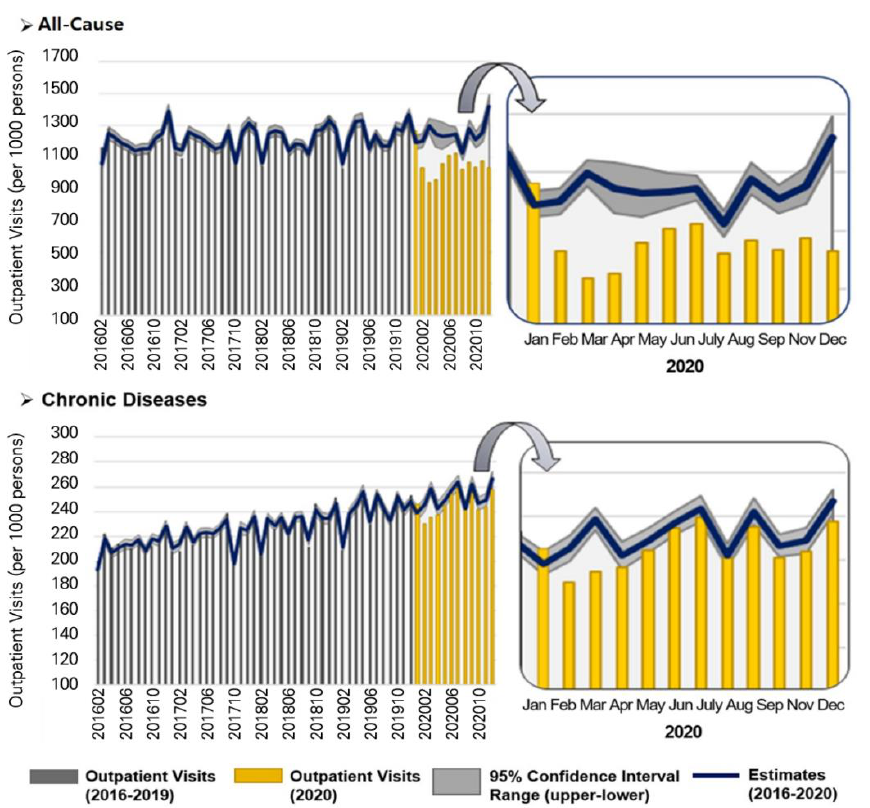
Figure 1. Outpatient Visits for All-cause and Chronic Disease (2016–2020). “Estimates” means the estimated outpatient visits based on the pre-pandemic period (2016–2020).